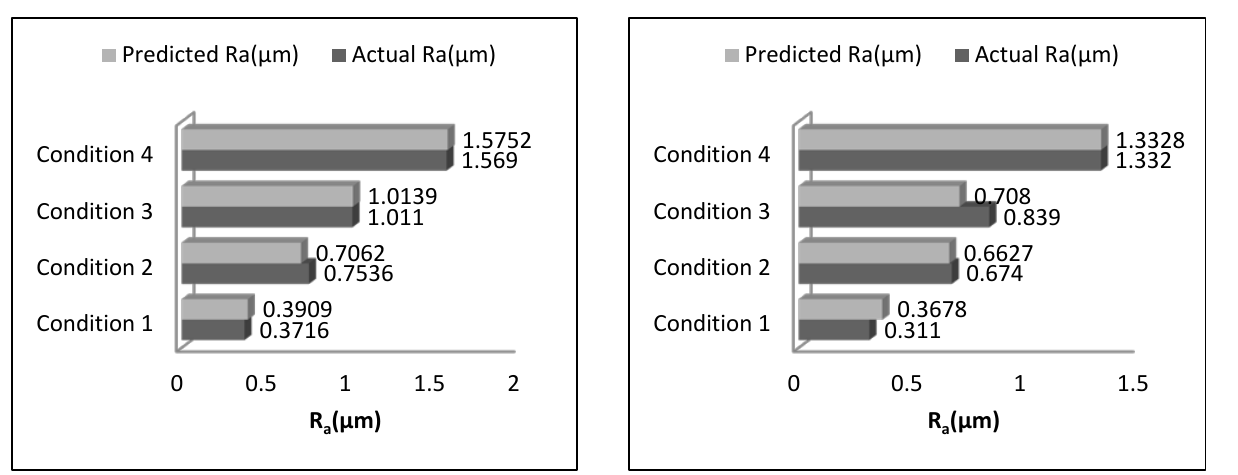
Fig. 6. Comparison of Ra values obtained from actual measurements and ANN method-(sample No. Vs. Ra (µm)) - For 0% Filler